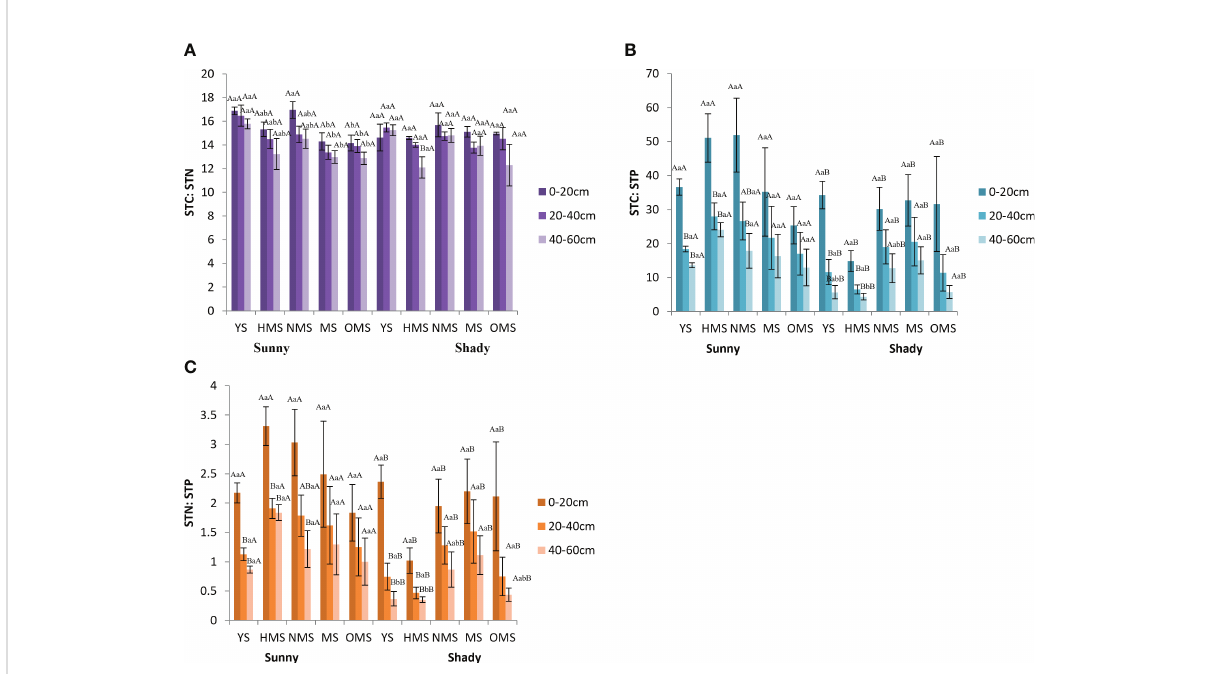
FIGURE 5 STC : STN (A) , STC : STP (B) , and STN : STP (C) . Different capital letters indicate signi fi cant differences in soil layers and different lowercase letters indicate signi fi cant differences forest ages, and additional different capital letters indicate signi fi cant differences in site conditions ( p< 0.05). YS, Young stage; HMS, Half-mature stage; NMS, Near-mature stage; MS, Mature stage; OMS, Over-mature stage. Sunny: Sunny slope, Shady: Shady